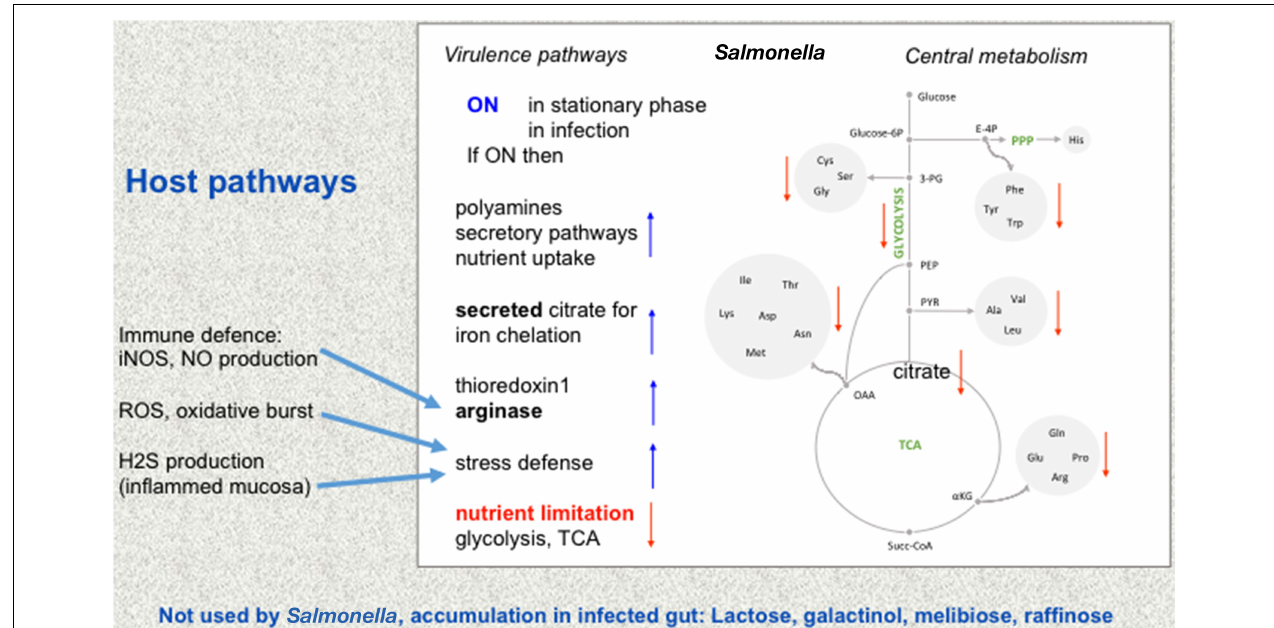
FIGURE 1 | Metabolic adaptation of Salmonella . Changes from intestinal to intracellular lifestyle in the mucosa and the resulting adaptations are depicted. The central metabolism of Salmonella is shown in the mid panel, while virulence pathways are shown on the left. Environments may change from rather nutrient-rich conditions to nutrient-restricted conditions (red letters) such as in infection, for instance when Salmonella is ingested with contaminated food. Amino acids are abbreviated by their three letter code. Other abbreviations: PPP, pentose phosphate cycle; E-4P, erythrose